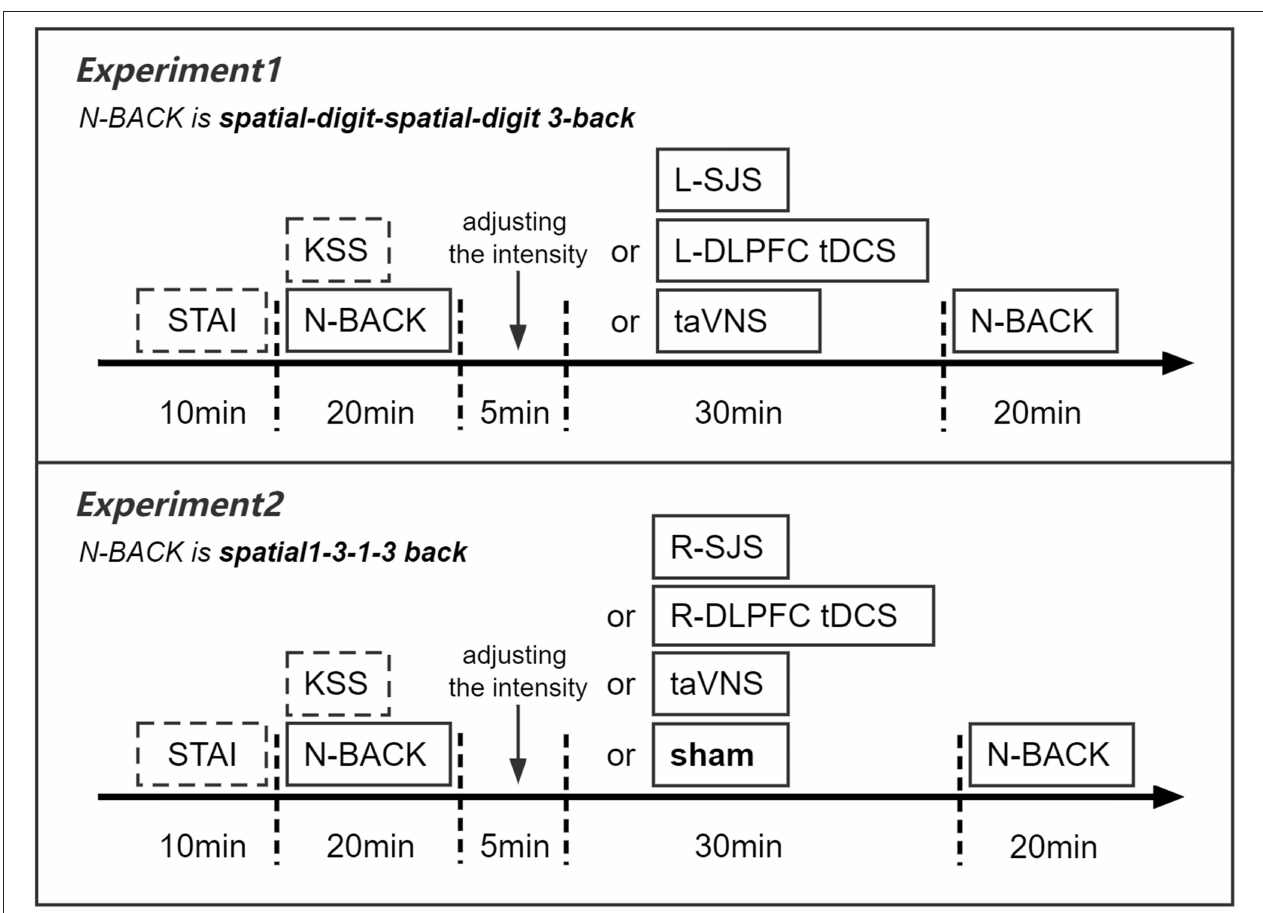
FIGURE 1 | Design of experiments 1 and